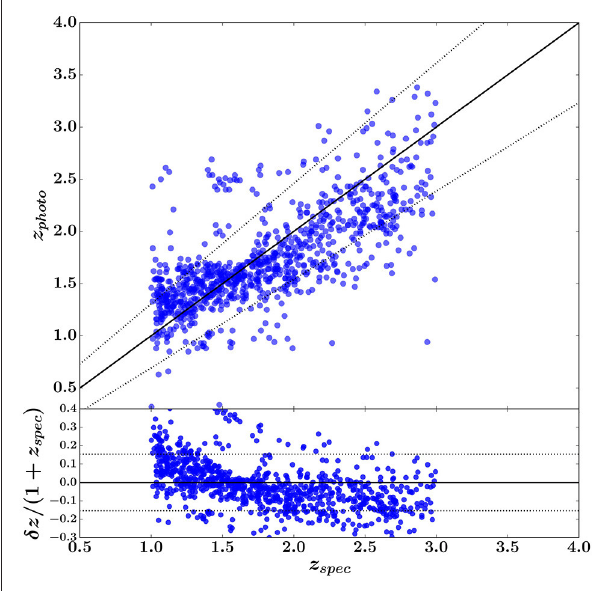
FIGURE 3 | (Top panel) Comparison between photometric and spectroscopic redshifts for 929 quasars in the Boötes field at 1.0 < z < 3.0. The solid line represents the one-to-one z phot = z spec relation, and the dotted lines correspond to z phot = z spec ± σ × (1 + z spec ). (Bottom panel) Standard dispersion between photometric and spectroscopic redshifts as function of the spectroscopic redshift. The solid and dotted lines are the same as in the top panel.